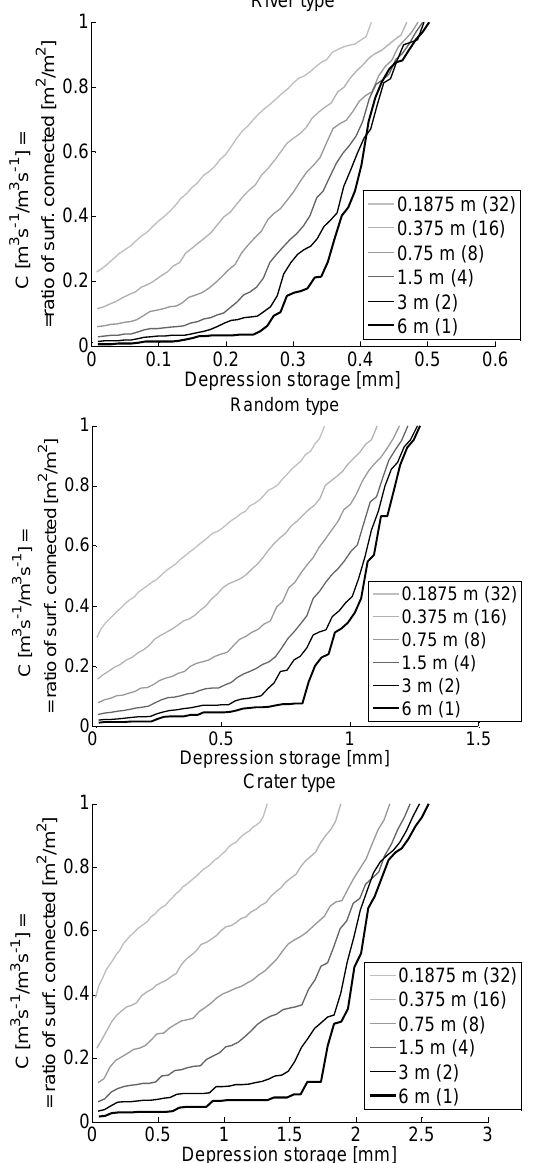
Fig. 11. Synthetic fields – effect of plot length on the averaged RSC Figure 11: Synthetic Fields – Effect of plot length on the averaged RSC function for the 4 Figure 11: Synthetic Fields – Effect of plot length on the averaged RSC function for the 4 function for the river, random and crater type microtopographies. “River”, “Random” and “Crater” type microtopographies. “River”, “Random” and “Crater” type microtopographies. The numbers in parentheses indicate the number of connectivity Figure 11: Synthetic Fields – Effect of plot length on the averaged RSC function for the 4 curves used for calculating the average RSC functions. All plots indicate the number of connectivity curves used for calculating the average RSC functions. 6 indicate the number of connectivity curves used for calculating the average RSC functions. 6 are 6m wide. “River”, “Random” and “Crater” type microtopographies. All plots are 6 m wide. 7 All plots are 6 m wide. 7 indicate the number of connectivity curves used for calculating the average RSC functions. 6 All plots are 6 m wide. 7